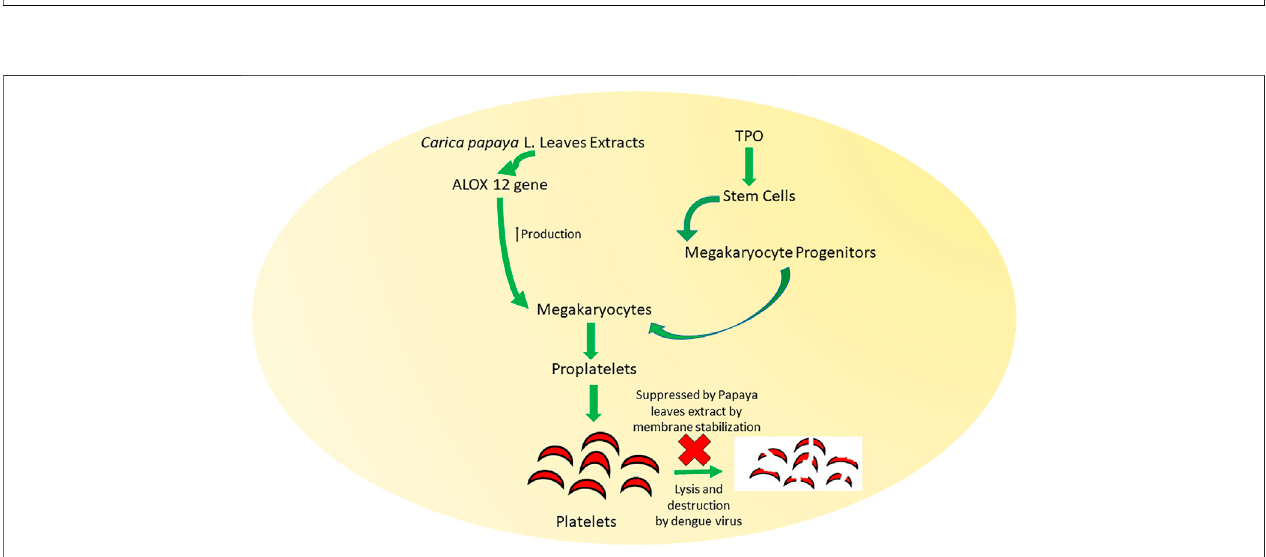
FIGURE8| MechanismsbehindtheroleofpapayaleavesinimprovingplateletcountbymembranestabilizationandproductionofALOX12gene. Caricapapaya L. leaf extract promotes the formation of megakaryocytes and megakaryocyte progenitors that induce the formation of proplatelets. Lysis and destruction of these proplatelets are also inhibited by Carica papaya L. leave